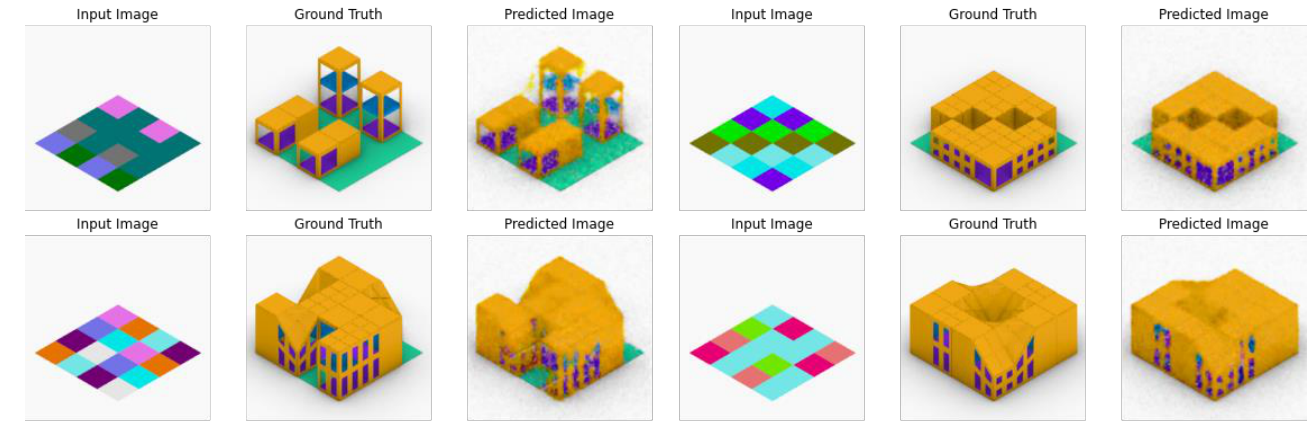
Figure 7. Captures from test C01 ( left ) and C02 ( right ).